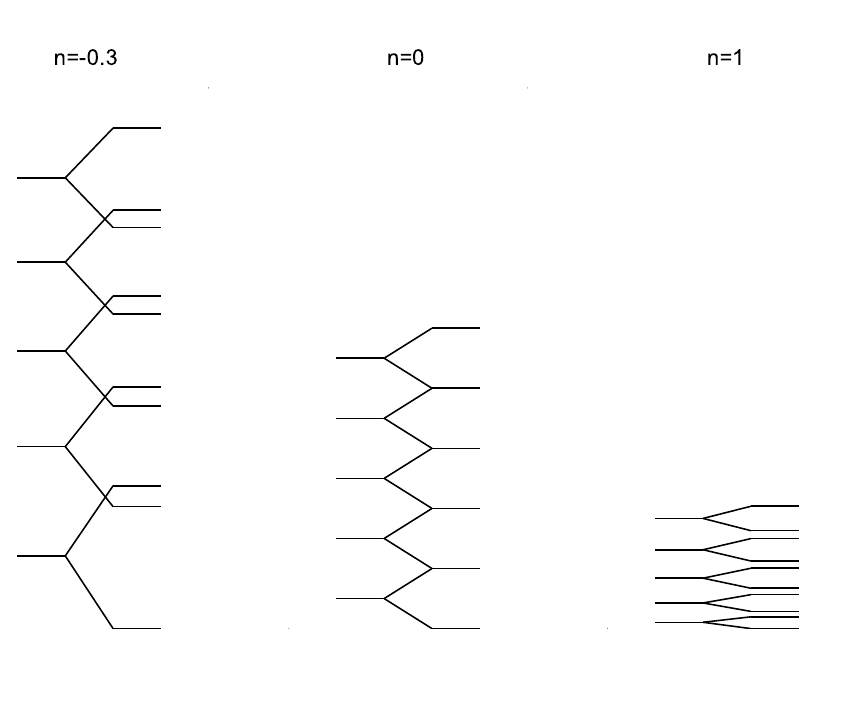
Figure 12: Comparison of schematic representation of the energy level splitting be- tween the magnetic field with n < 0 and that with n > 0, along with a case of uniform magnetic field ( n =